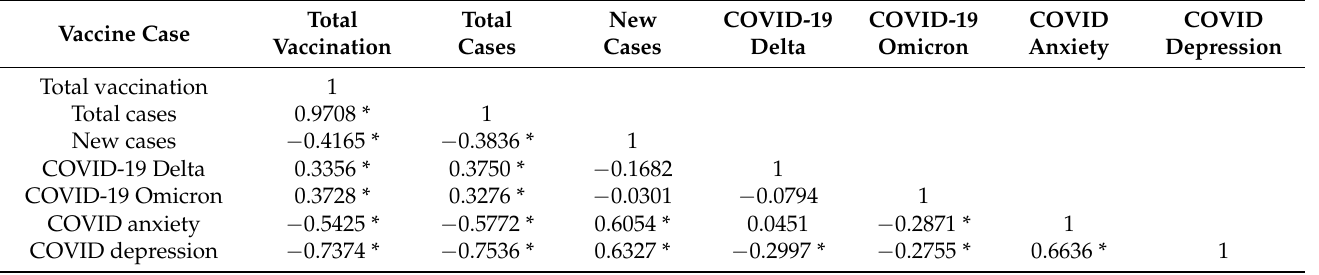
Table 2. The Pearson correlations among total vaccination, total cases, new cases, COVID-19 Delta, COVID-19 Omicron, COVID anxiety, and COVID